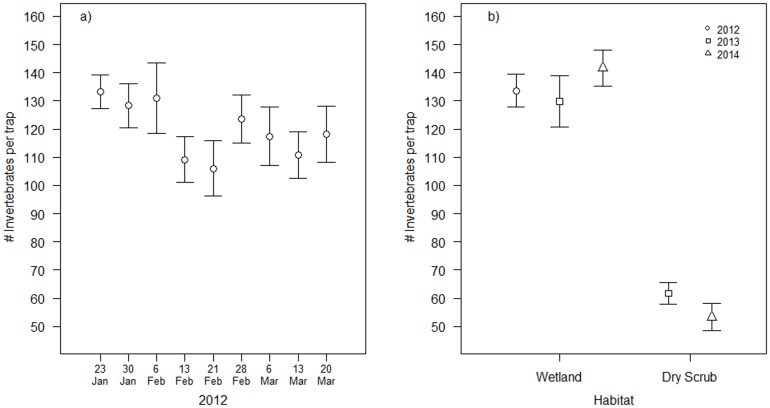
a) Mean numbers of invertebrates per trap (±SE) within wet habitat between 23 January-19 March 2012; and 1b) Wet habitats and dry habitats between 23rd–29th January 2012, 22nd–30th January 2013, and 21st–27th January 2014.